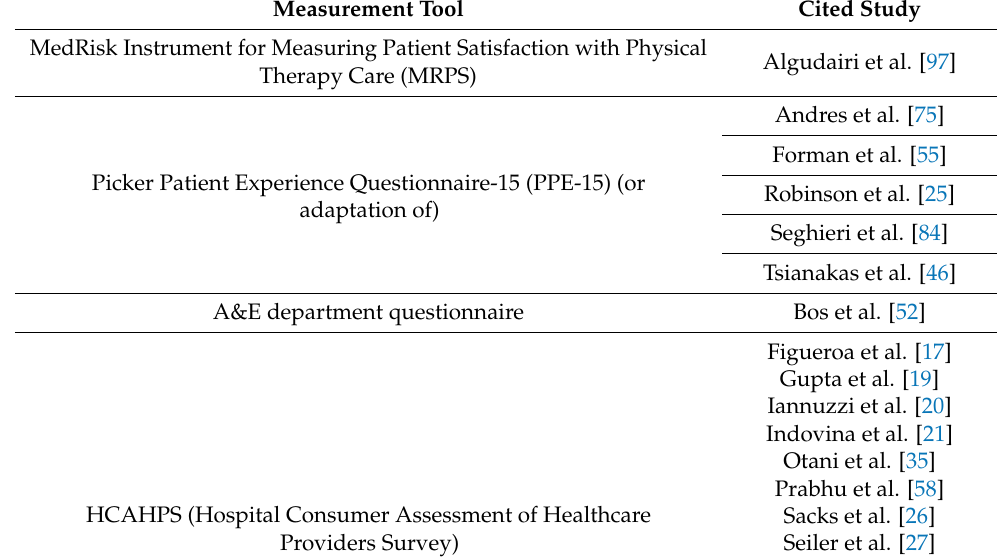
Table 2. Tools cited within the included primary studies measuring patient satisfaction with care or quality of service within acute